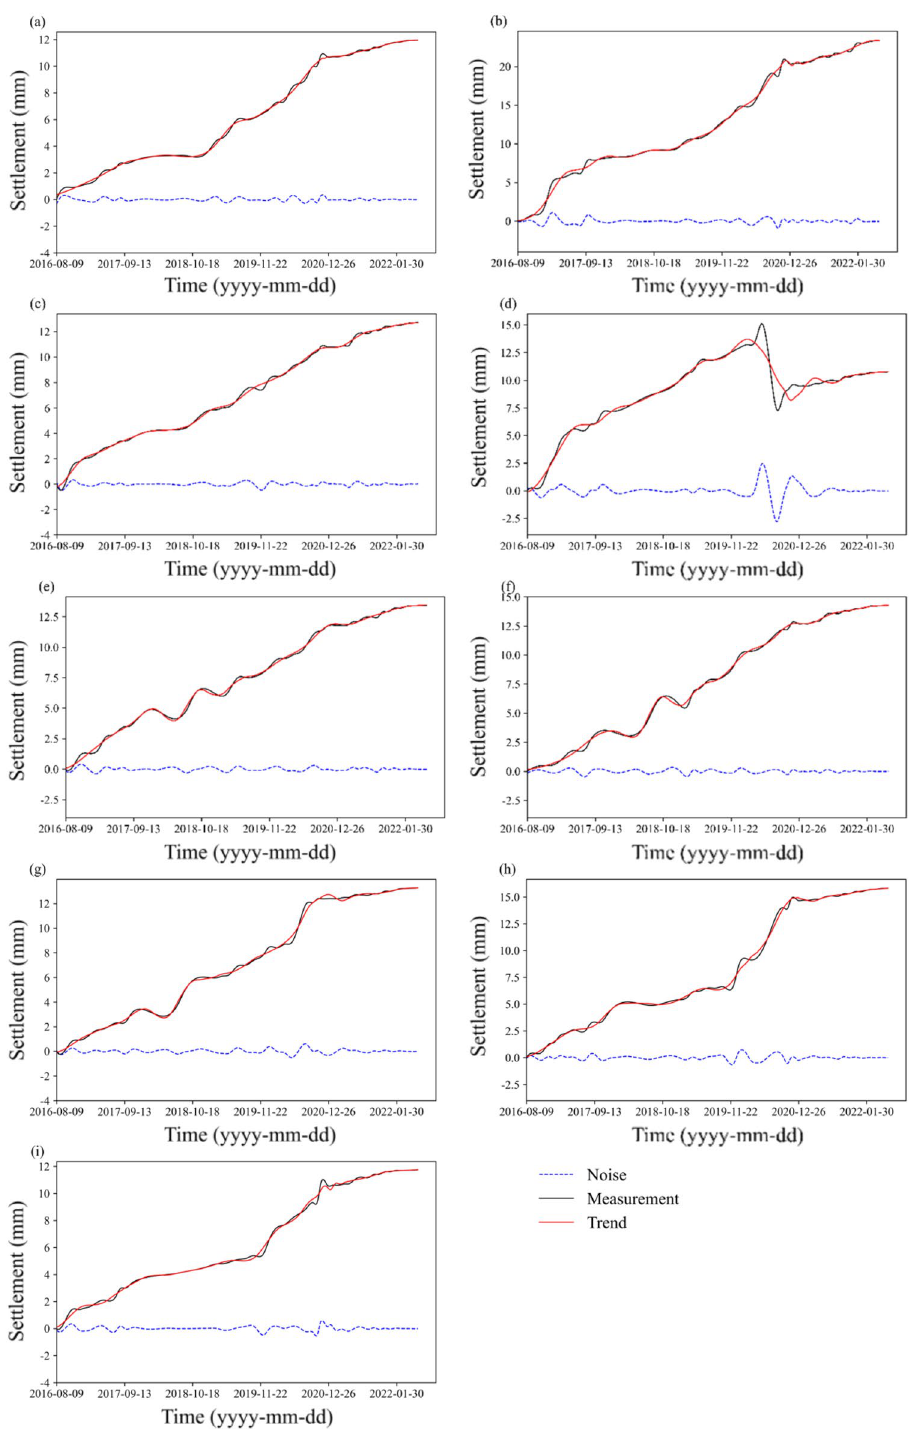
Figure 5. Settlement data processing results of the model with wavelet analysis: ( a ) TP1-1; ( b ) TP1-2; ( c ) TP1- 3; ( d ) TP2-1; ( e ) TP2-2; ( f ) TP2-3; ( g ) TP3-1; ( h ) TP3-2; and ( i )